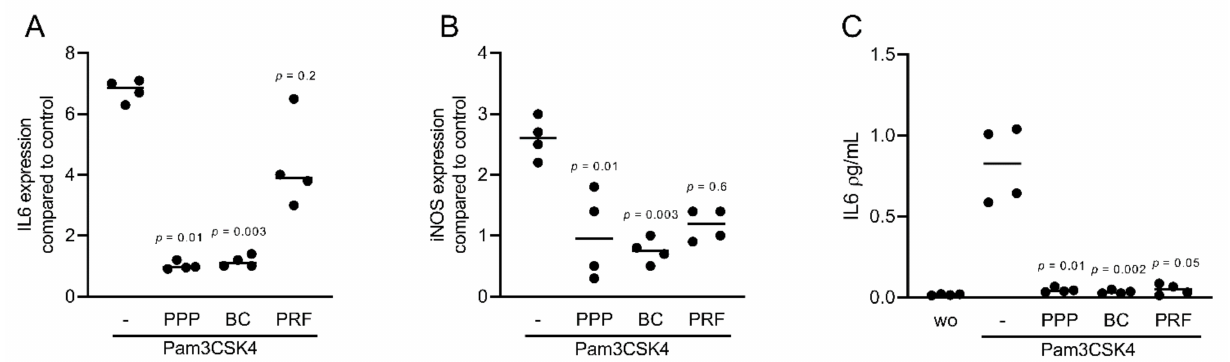
Figure 8. PPP, BC, and PRF can reduce inflammation provoked by TLR2 agonist in ST2 cells. The ST2 cells were exposed to 10% PPP, BC, and 30% PRF lysates in the presence of 5 µ g/mL Pam3CSK4, agonists of TLR2. ( A , B ) Data show the x-fold changes of IL6 and iNOS gene expression, and ( C ) the concentration of IL6 in the supernatant of ST2 cells. n =